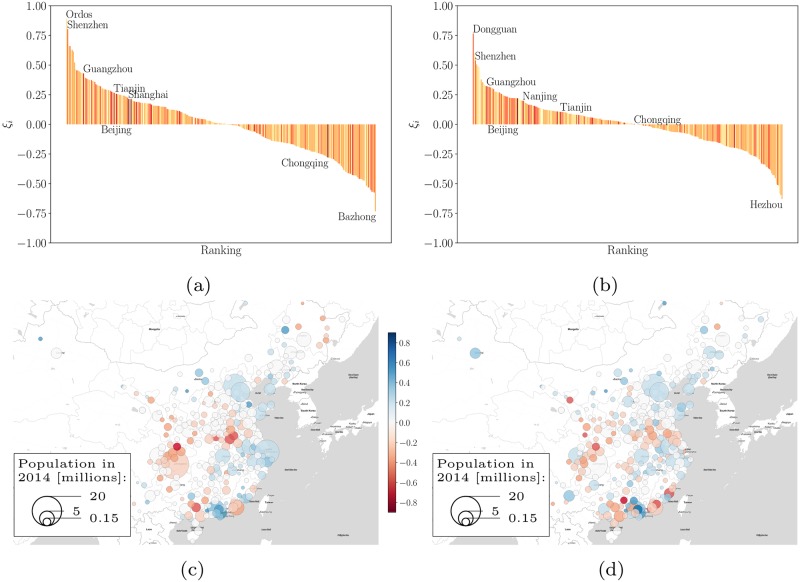
Local measure of urban dynamics and reference scale for ranking Chinese cities, the symbol areas are scaled according to the registered population.Scale independent ranking of cities in terms of Gross Domestic Product (a) and built area (b). Spatial distribution of the scores from the scale independent measure [21]: GDP (c) and built up surface area (d). The ranking shows that large coastal cities tend to overperform for China in the scale independent ranking.